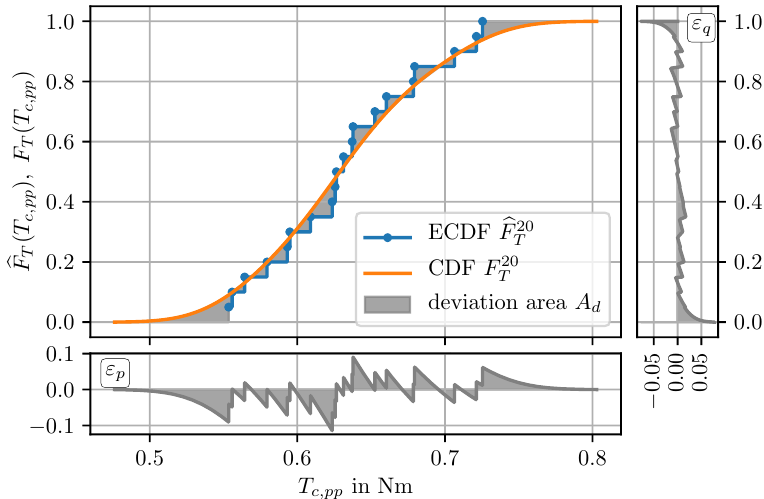
Figure 4. Cumulative distribution functions created using the first 20 samples. Appended axes show the deviation of the empiric CDF quantile values ε q ; deviation area A d = 7.95